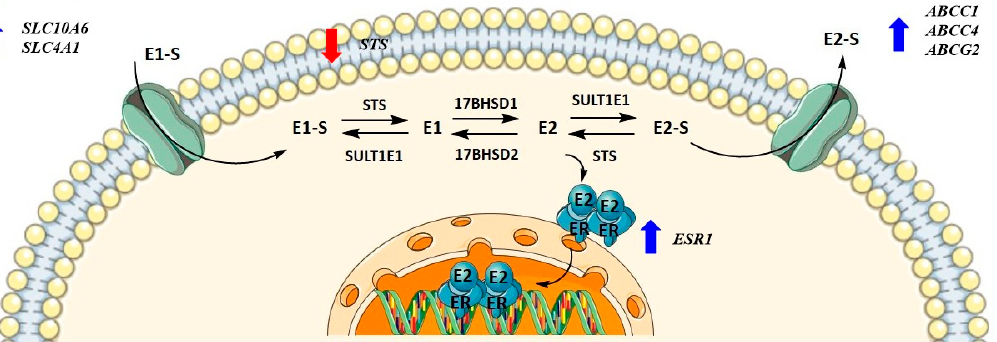
Figure 7. Changes in gene expression levels due to high concentrations of Cimicifuga racemosa extract in the KLE cell line (derived from poorly differentiated endometrial cancer).